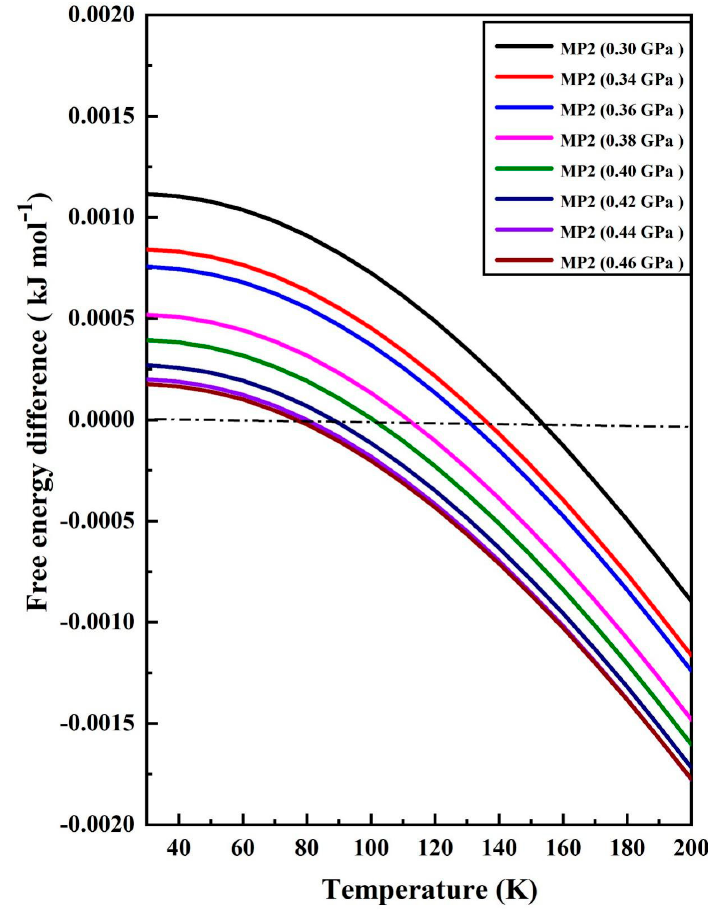
Figure 6. The Gibbs free energy difference between ice phases IX and XIII as a function of temperature under different pressures. The positive values indicate that the phase XIII is more stable than phase IX.